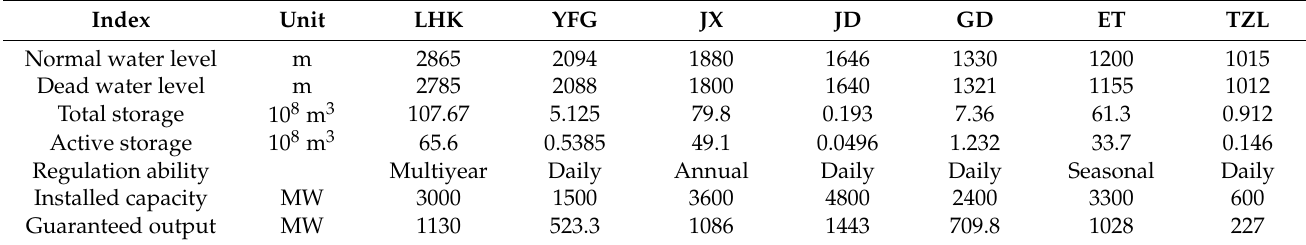
Table 1. Characteristic parameters of the Yalong River cascade